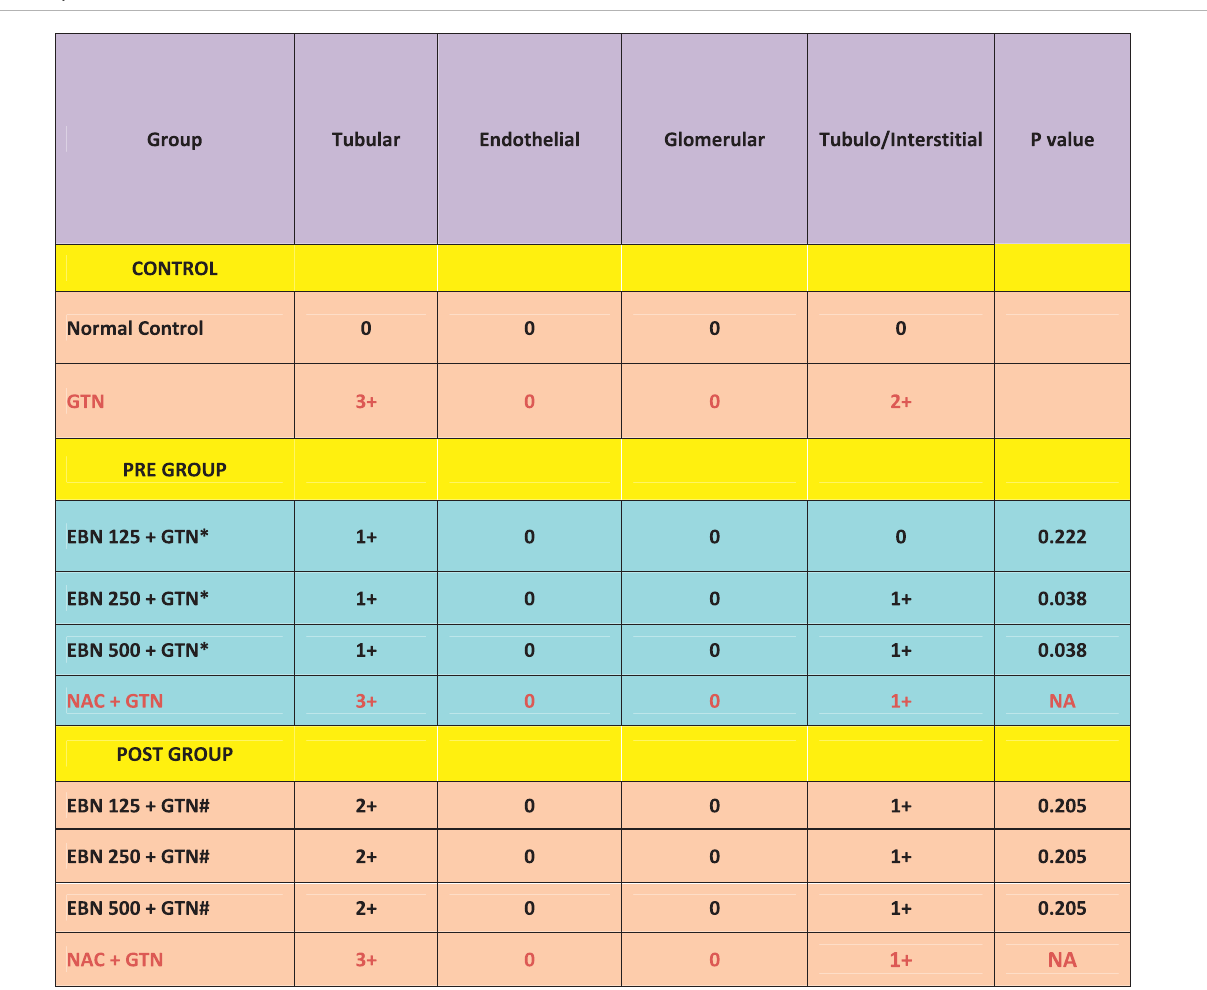
TABLE 2 | Plots of EGTI